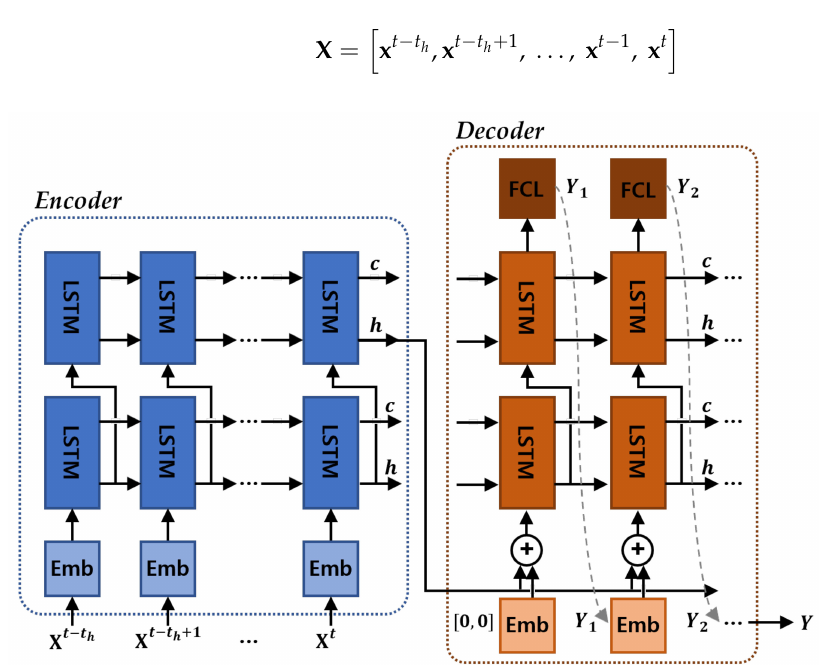
Figure 3. Peaky LSTM encoder–decoder